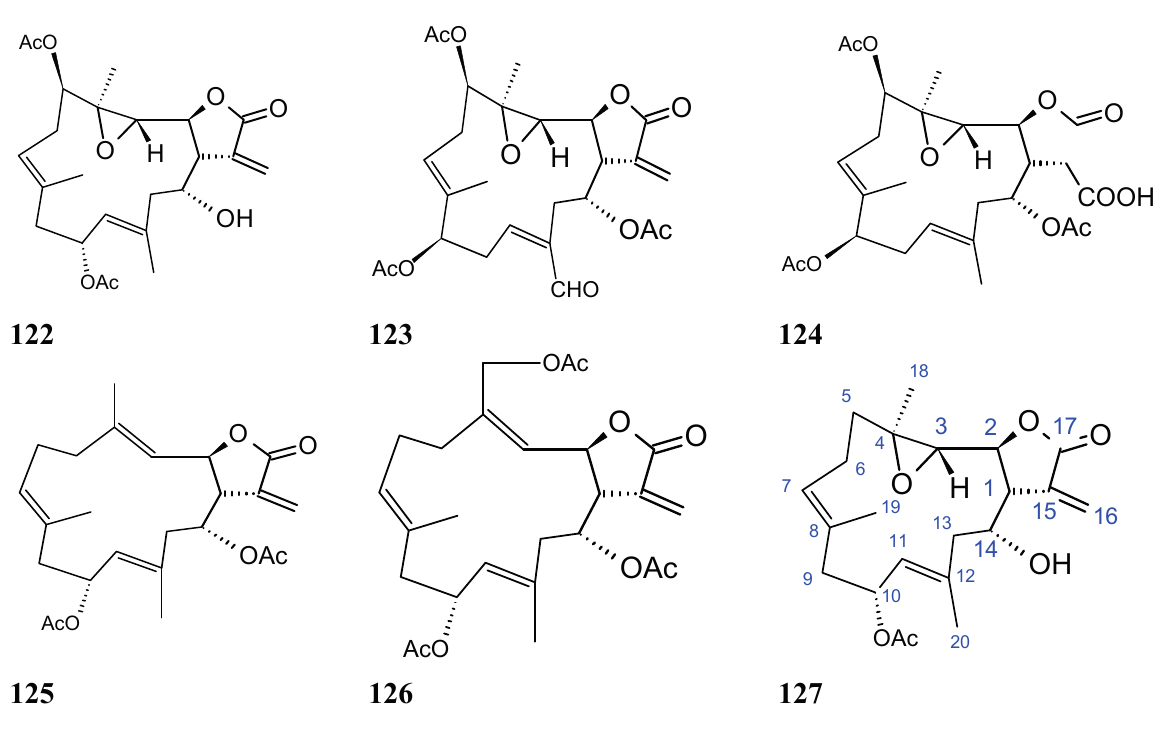
Figure 43. Michaolides and derivatives 121 – 127